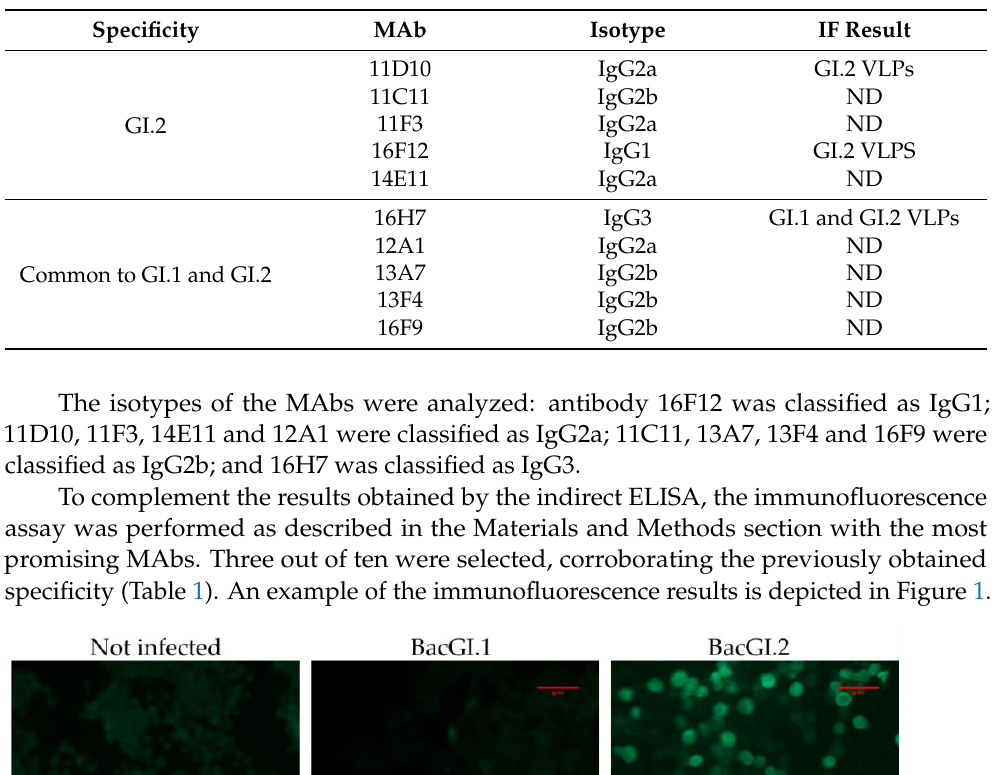
Table 1. Characterization of monoclonal antibodies. Specificity